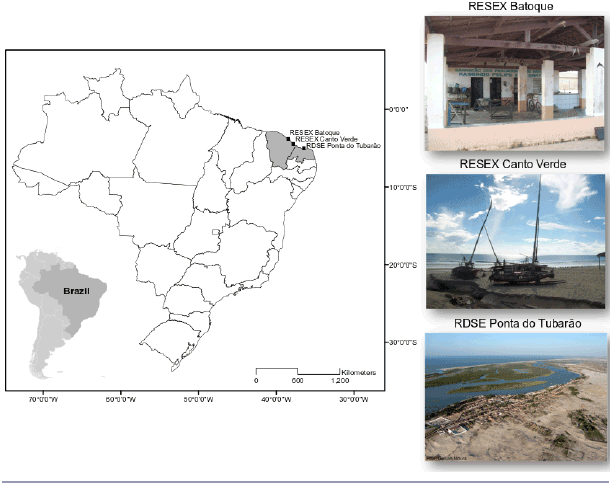
Fig. 3 . Study area located on the Brazilian northeastern coast, highlighting the reserves located in the states of Rio Grande do Norte (RDSE Ponta do Tubarão) and Ceará (RESEX Batoque and RESEX Canto Verde). Pictures on the left, from top to bottom: the fisher association in RESEX Batoque, rafts (the main fishing craft in RESEX Canto Verde), and the estuary in RDSE Ponta do